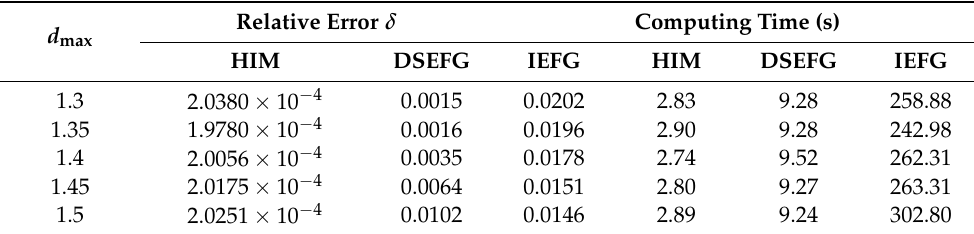
Table 1. Comparison of relative error and computing time when d max is different.